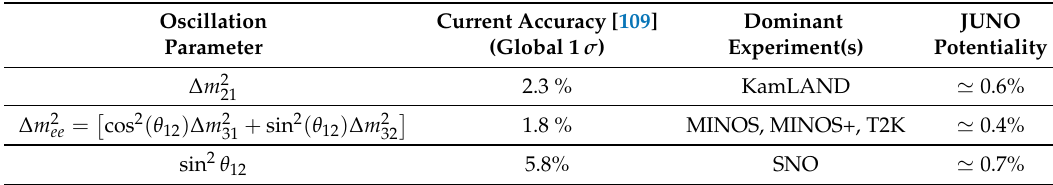
Table 3. Expected accuracy with the use of JUNO data, compared with the present one, for the mass and mixing parameters for which a significant improvement is expected. The leading experiments for the present parameters determination are also reported. The JUNO expected accuracies are recovered by [42] and by the most recent collaboration’s